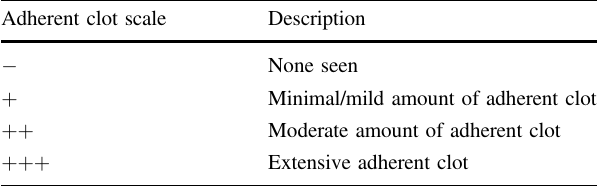
Table 1 Description of the adherent clot scale